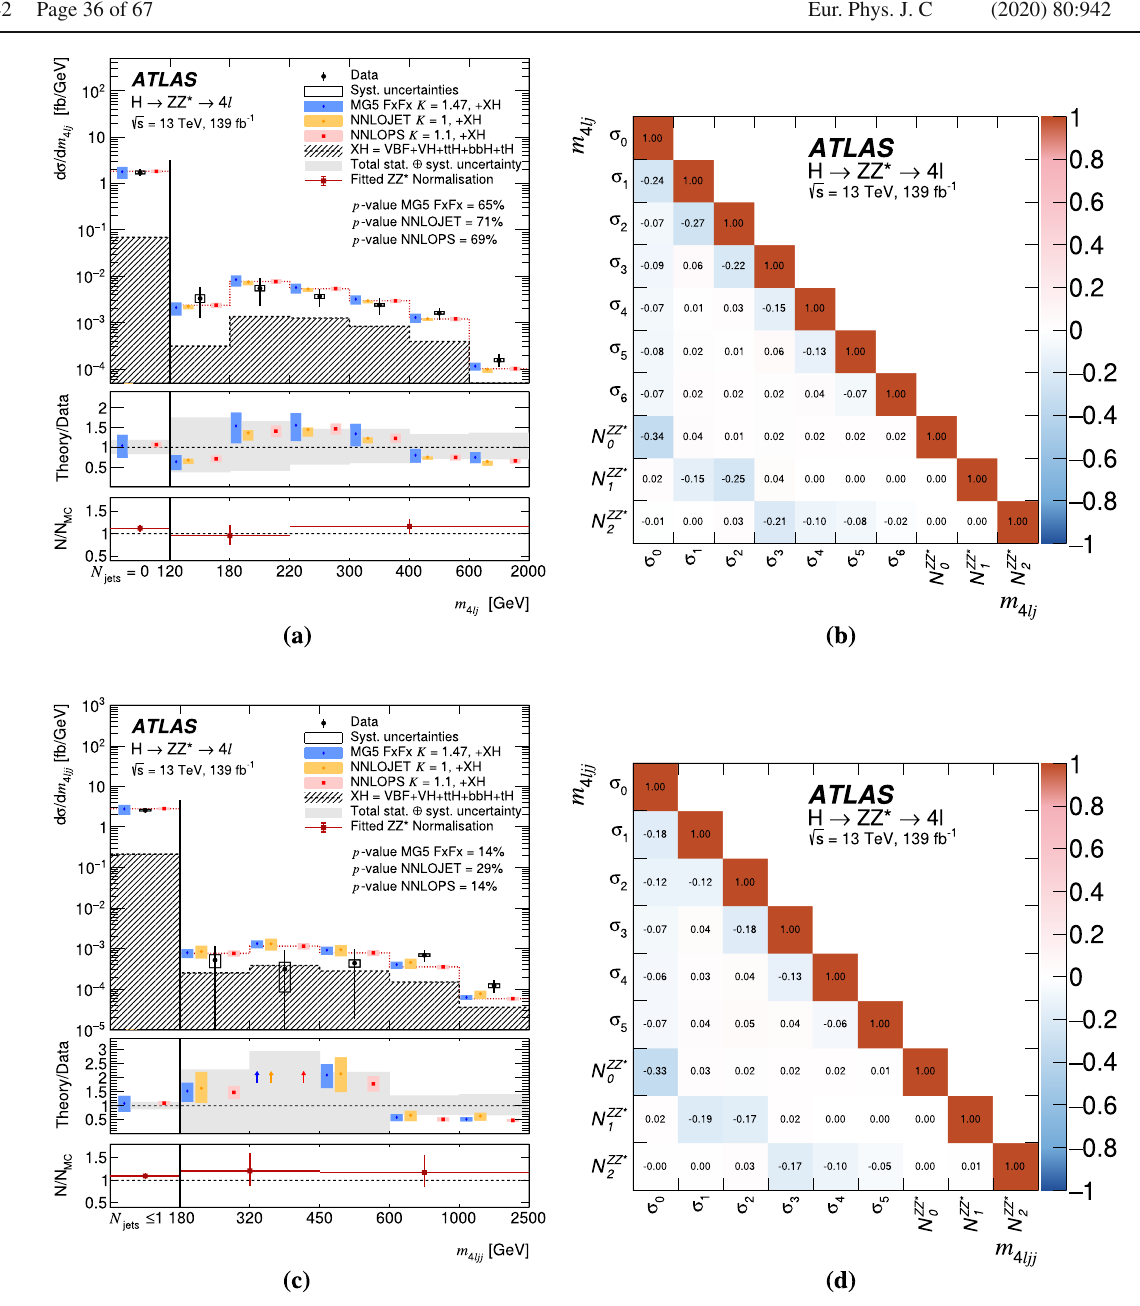
Fig. 30 Differential fiducial cross sections for a the invariant mass of the four-lepton plus jet system, in events with at least one jet, and c the invariant mass of the four-lepton plus dijet system, in events with